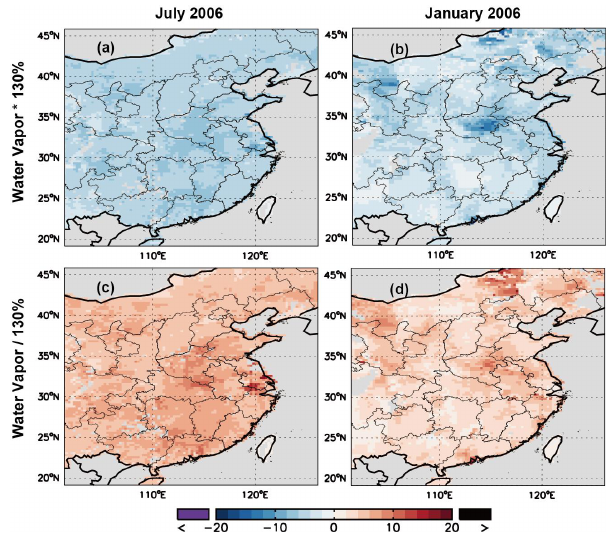
Fig. 4. Spatial distribution of percentage differences between mod- eled NO 2 columns with and without adjustments in tropospheric water vapor content. (a, b) The water vapor content is scaled up by 130% in (a, b) and scaled down by 130% in (c, d) .